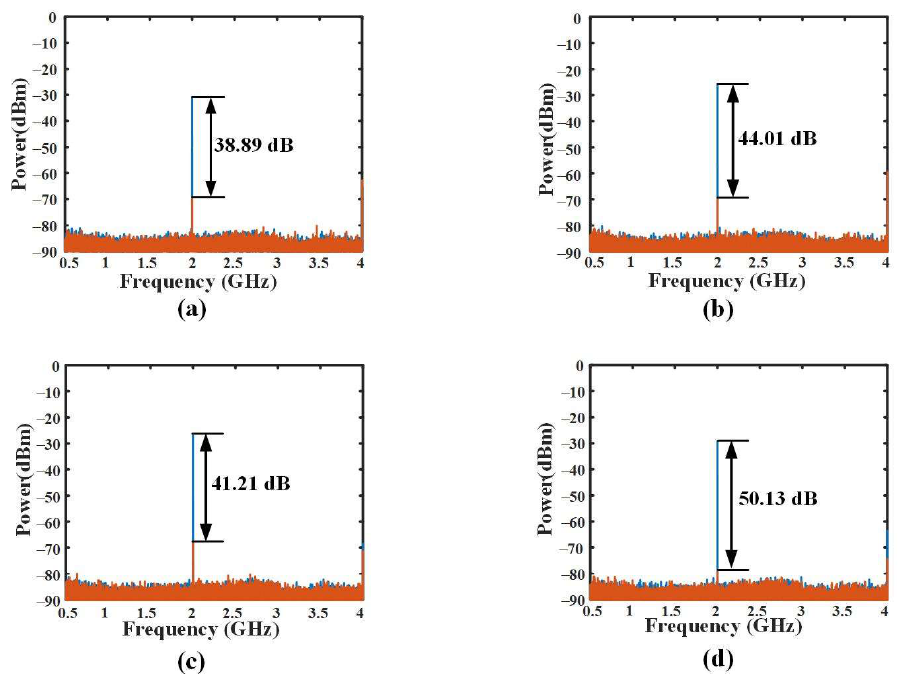
Figure 9. Electrical spectra of the IF signals down-converted from ( a ) the RF signal at 10 GHz and the corresponding image signal at 6 GHz, ( b ) the RF signal at 18 GHz and the corresponding image signal at 14 GHz, ( c ) the RF signal at 22 GHz and the corresponding image signal at 26 GHz, ( d ) the RF signal at 30 GHz and the corresponding image signal at 34 GHz. (RF signal: blue line; image signal: red line).